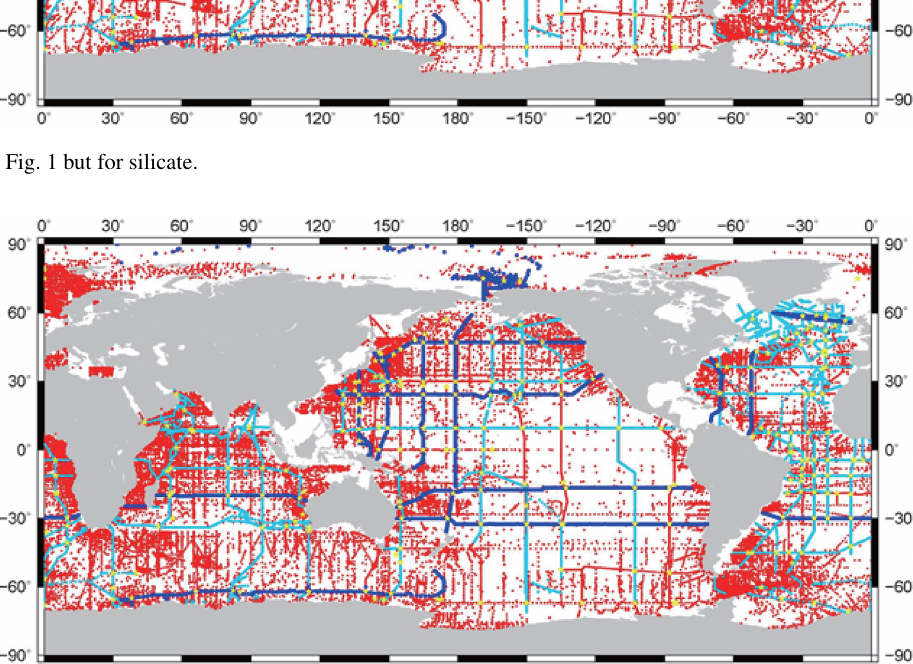
Figure 4. Same as Fig. 1 but for